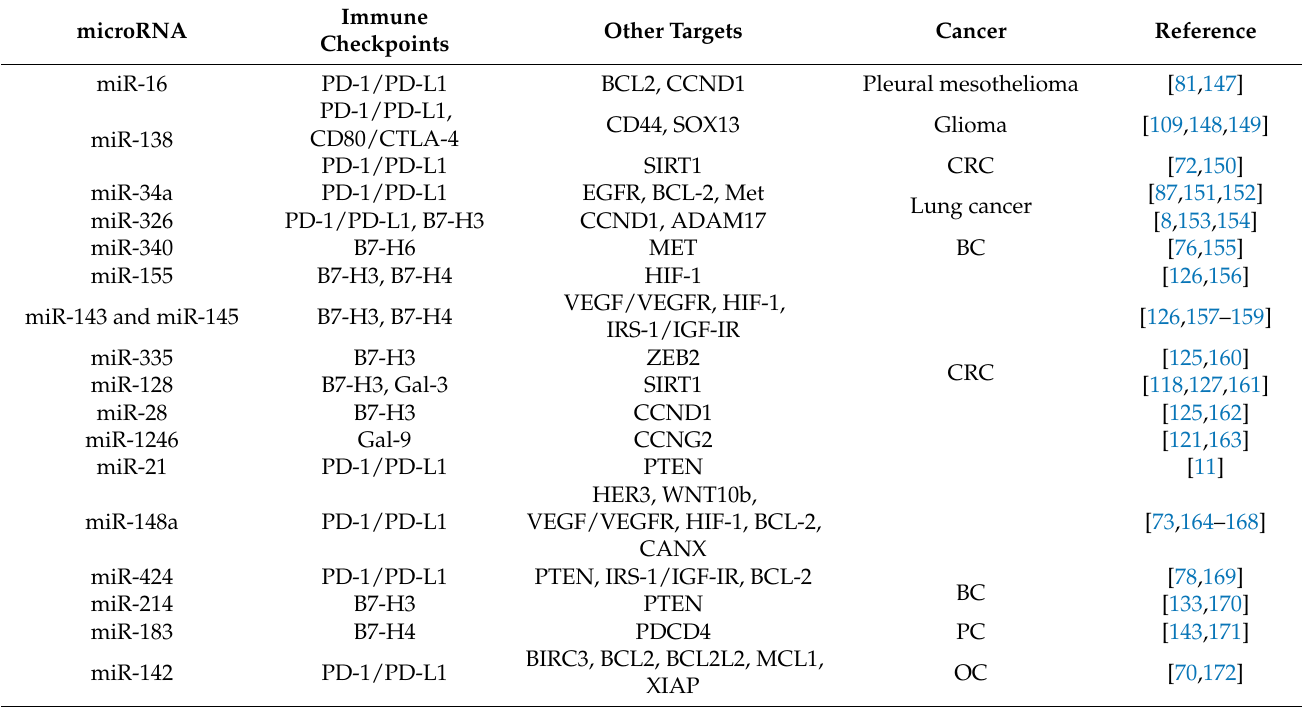
Table 2. MiRNAs regulating immune checkpoints as well as other cancer relevant